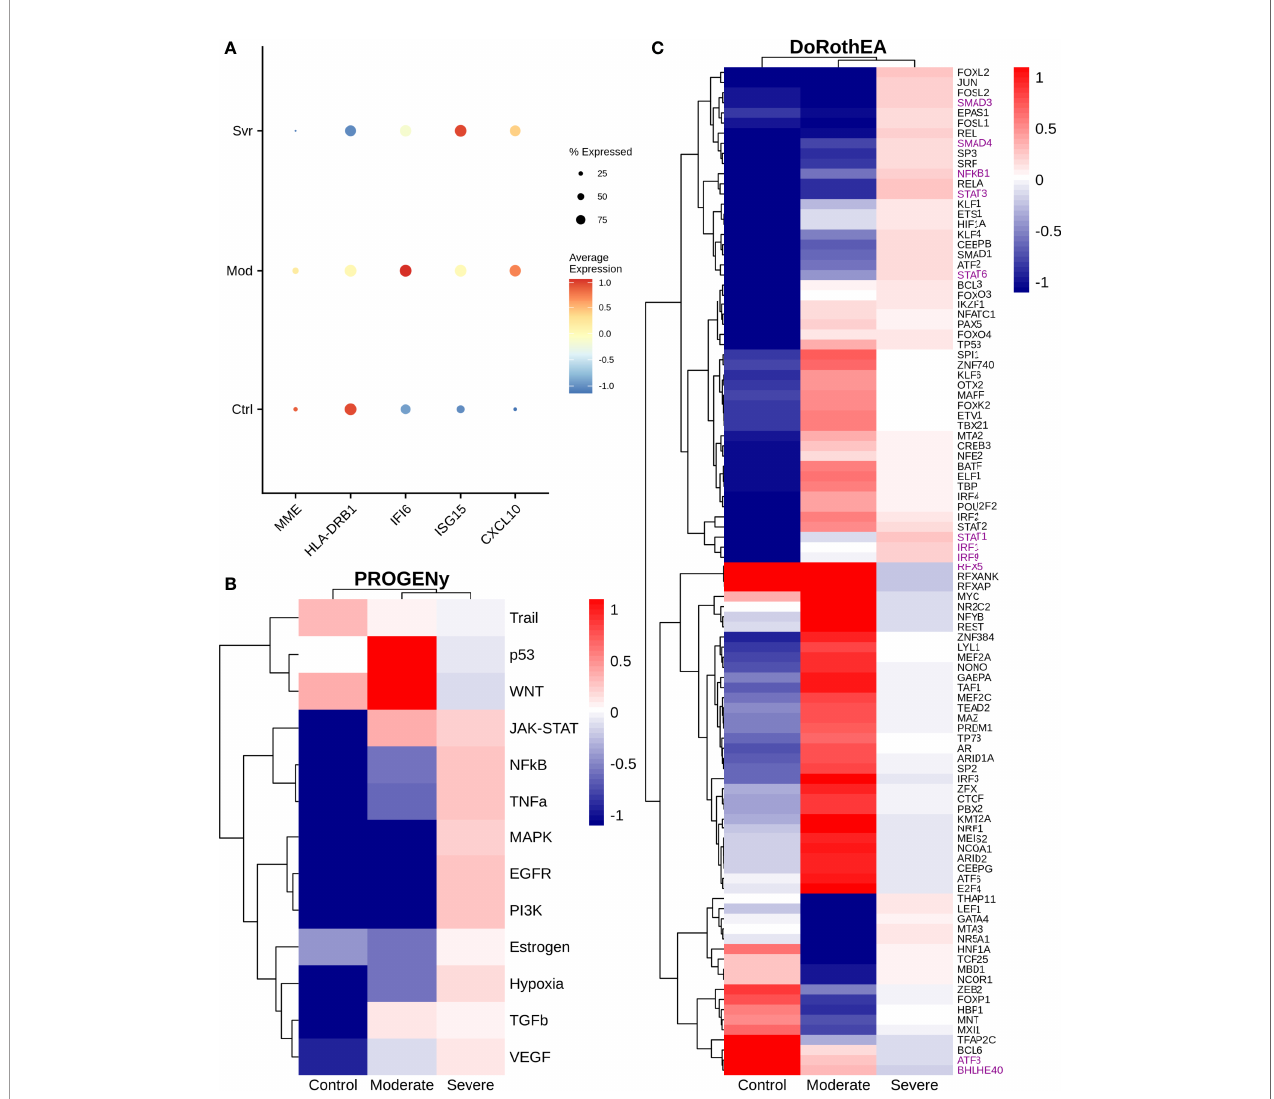
FIGURE 5 | Gene expression and inferred transcriptional factor activities of monocytes among patients. (A) Expression of several marker genes across patients, the point size and colorbar are related to the percentage of cells that express a gene and the average expression, respectively. (B) Predicted pathway activity among patients. (C) Transcriptional factor activity of monocytes inferred using single cell data. Colorbar is related to activation (red) and inactivation (blue)